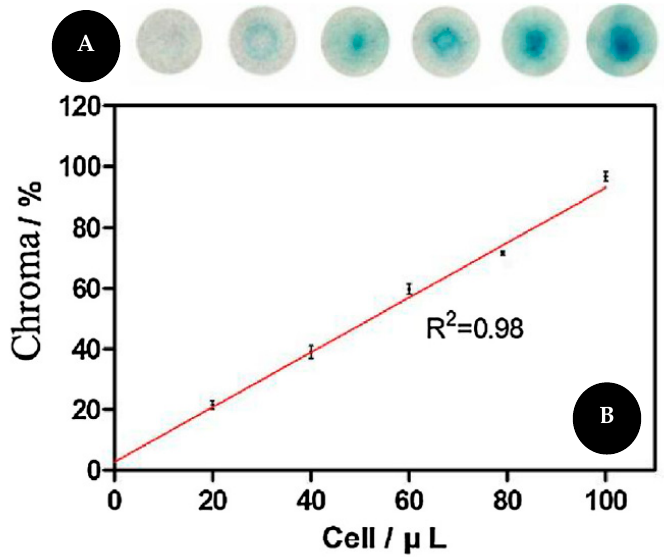
Figure 8. ( A ) Pictures of the colorimetric assay for telomerase activity ( B ) and corresponding graphic with linear relationship between MB and telomerase concentration. Reproduced and adapted with permission from [63].